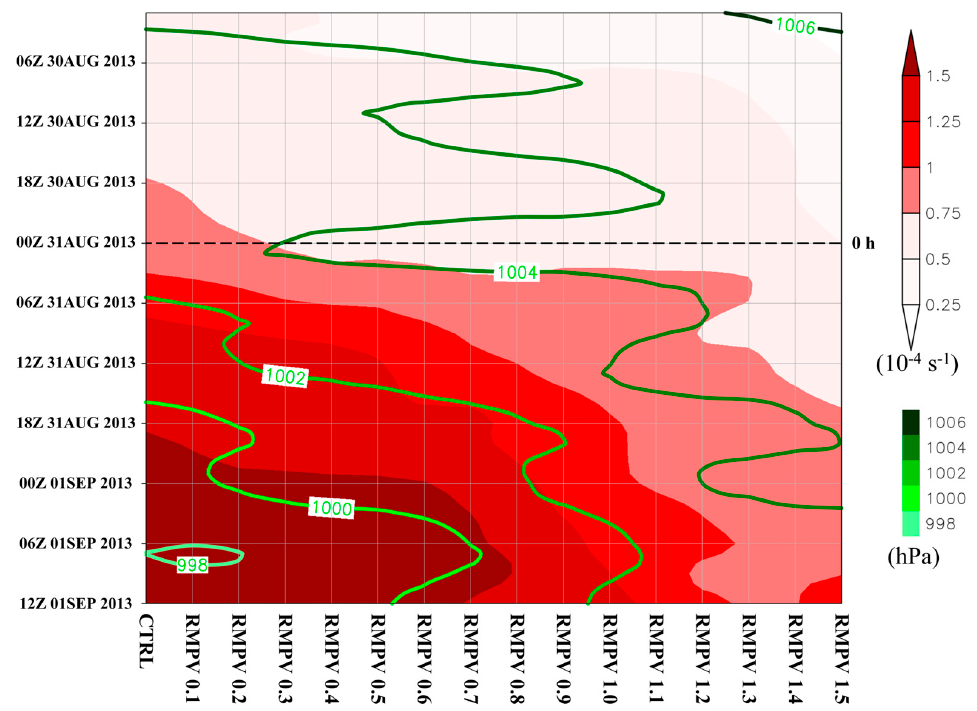
Figure 10. Time series of low-level vorticity (averaged from 925 hPa to 700 hPa) (shading; 10 − 4 s − 1 ) and sea-level pressure (contours; hPa) derived from each experiment averaged over a 2°-radius area centered at 700 hPa vortex center in every 1 h. Time ranges from 0000 UTC 30 August ( − 24 h) to 1200 UTC 1 September (+36 h).